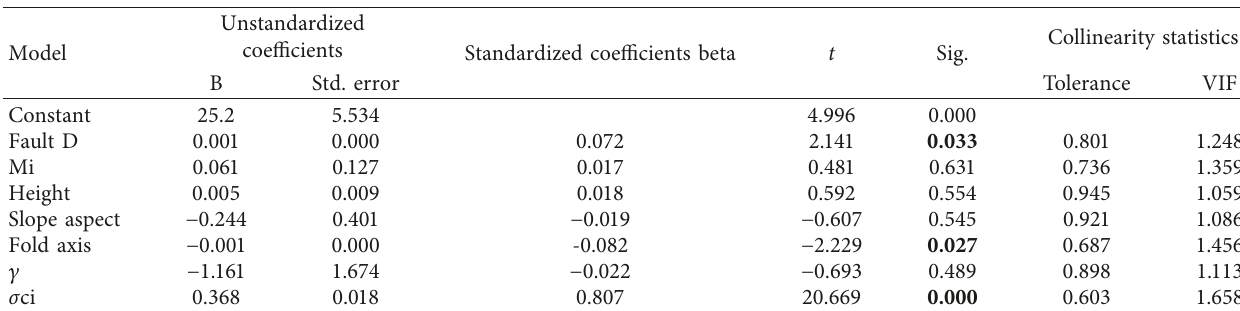
Table 5: The coefficients.